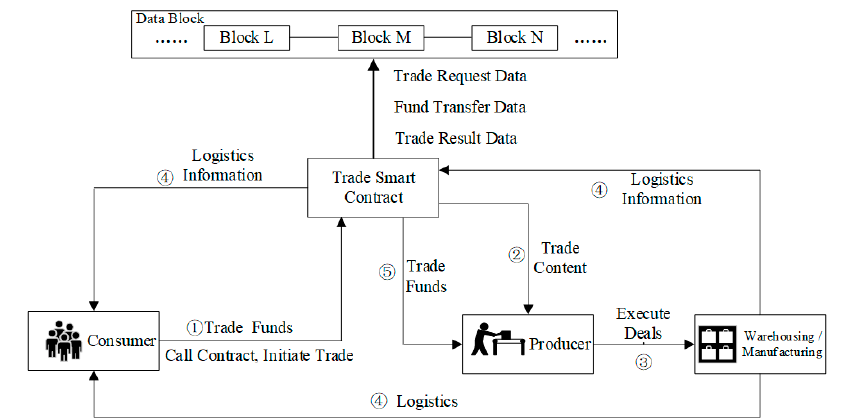
Figure 4. Trade smart contract workflow.